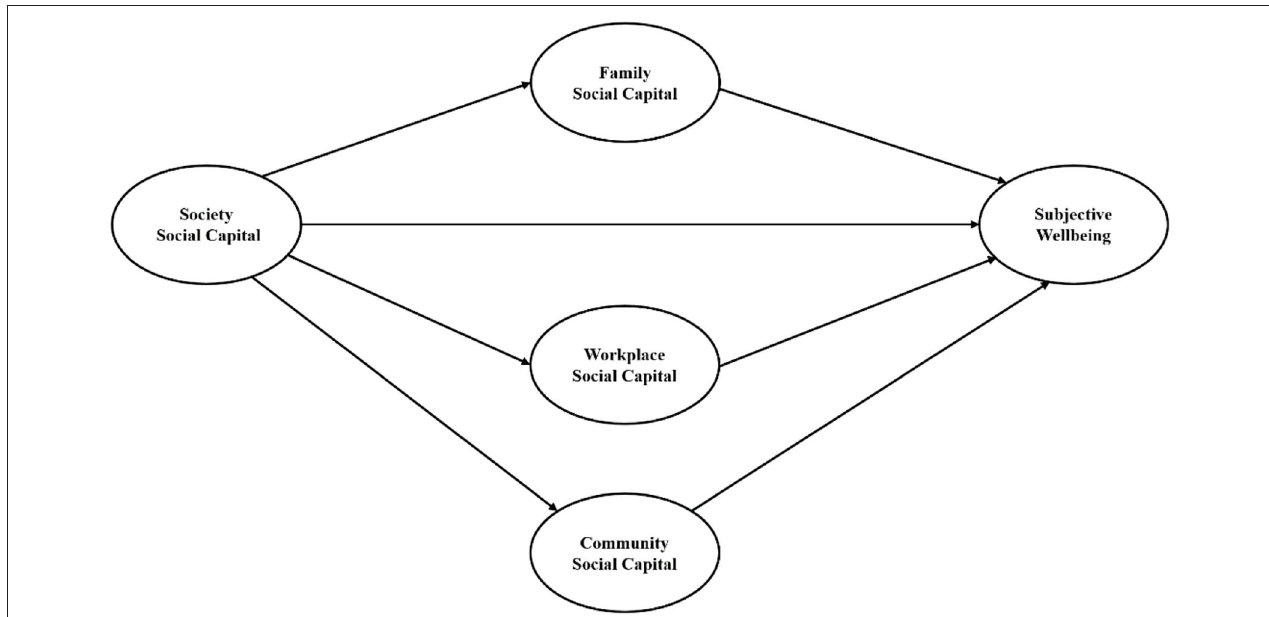
FIGURE 1 | The hypothesized model.